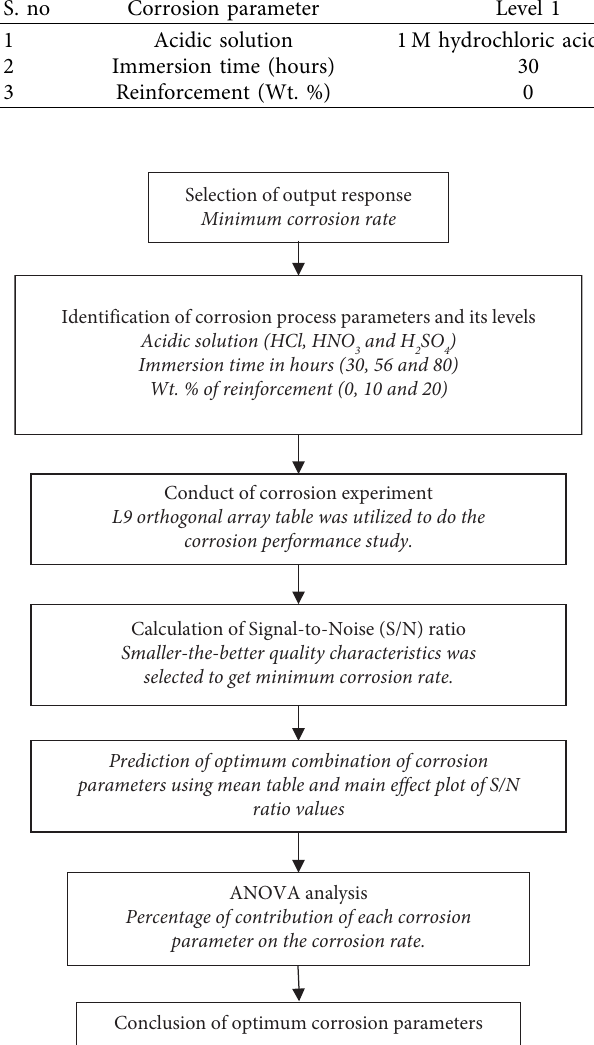
Figure 3: Taguchi procedure for optimization of corrosion